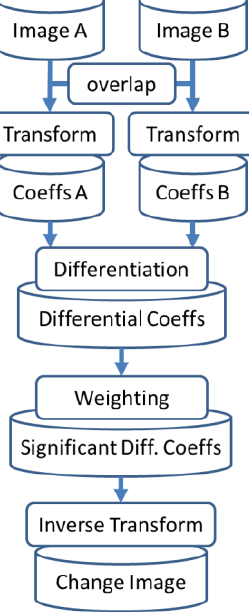
Figure 11. Flow chart of the Curvelet-based change detection.